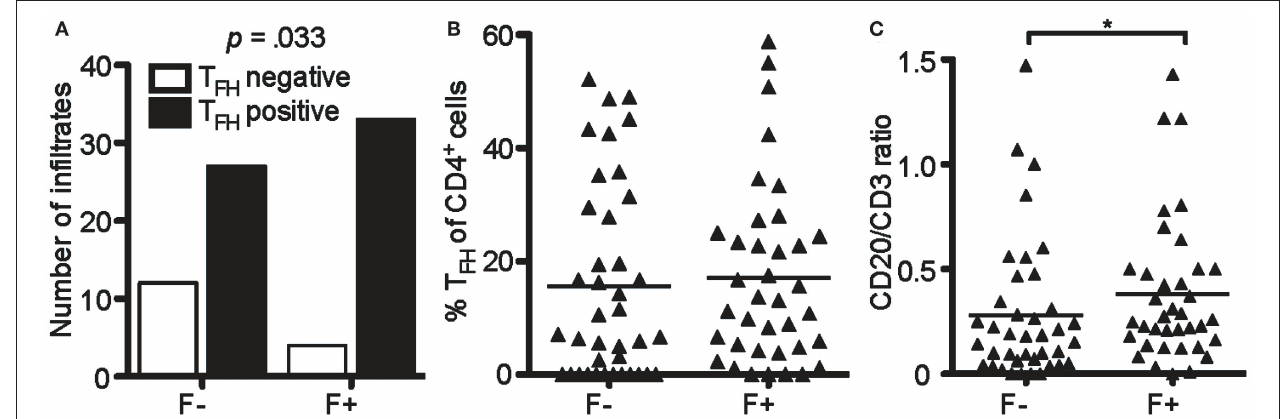
FIGURE 7 | B cells enrich in lymphoid aggregates. (A) Absolute number of infiltrates that were positive for T FH in follicle-like structures (F + ) and less defined infiltrates (F-). Fisher’s exact test, N = 76, X 2 (1) = 4.55, p = 0.048, d = 0.505. (B) Mean percentage of T FH cells defined as CD4 + CXCR5 + cells of CD4 + cells in two serial FFPE sections of follicle-like structures (F + ) and less defined infiltrates (F-) in SPMS brains and spinal cords. F-, M = 15.57, SD = 17.13, n = 39; F + , M = 17.04, SD = 15.85, n = 37. Mann Whitney test, U = 635.0, p = 0.369. (C) CD20/CD3 ratio in follicle-like structures (F + ) and less defined infiltrates (F-) based on IF co-staining of CD3 and CD20. F-, M = 0.28, SD = 0.33, n = 39; F + , M = 0.38, SD = 0.34, n = 37; Mann Whitney test, U = 525.5, p = 0.042. * p <